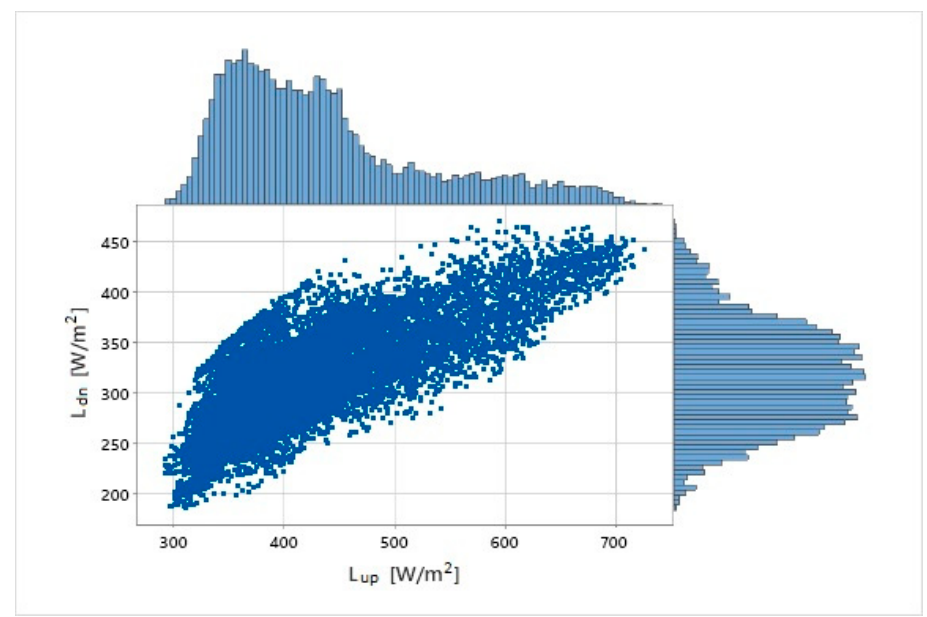
Figure 7. Monthly mean values of the short and longwave irradiances including the net allwave irradiances in W/m 2 .